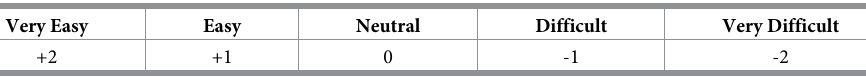
Table 31. Scoring system for questions about